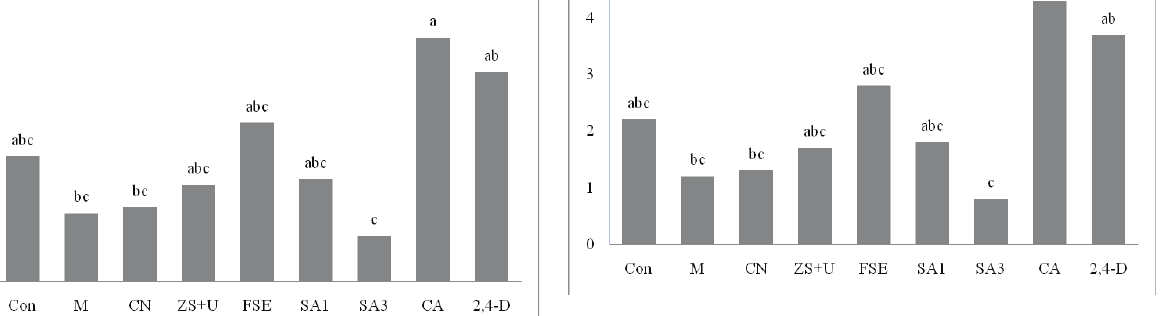
Figure 4: Effect of foliar-applied methanol (M), calcium nitrate (CN), zinc sulfate + urea (ZS+U), fermented sugarcane extract (FSE), sali- cylic acid 1 and 3 mM (SA1 and SA3), citric acid (CA), 2,4-dichloro- phenoxyacetic acid (2,4-D) and water (Con) on peel color of ‘Thomp- son Navel’ orange. 1= yellow, 2= pale orange, 3= orange, and 4= deep orange. Differences in column headings denote statistically